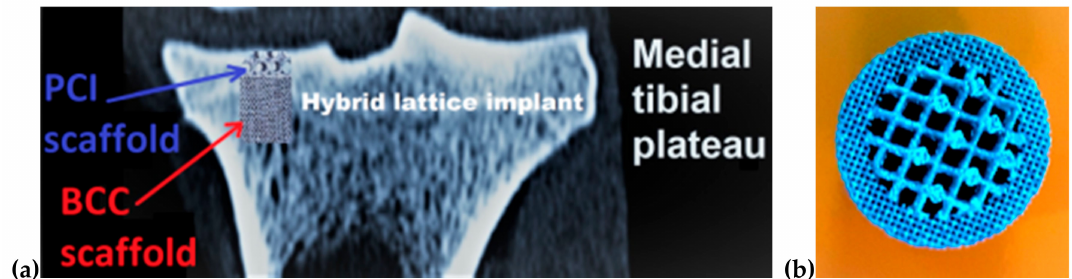
Figure 9. Concept of hybrid lattice implant: ( a ) Simulation done on computed tomography (CT) image of proximal tibia (coronal section); ( b ) SLM-manufactured from Ti6Al7Nb powder (border—BCC sca ff old, and middle PCI—sca ff